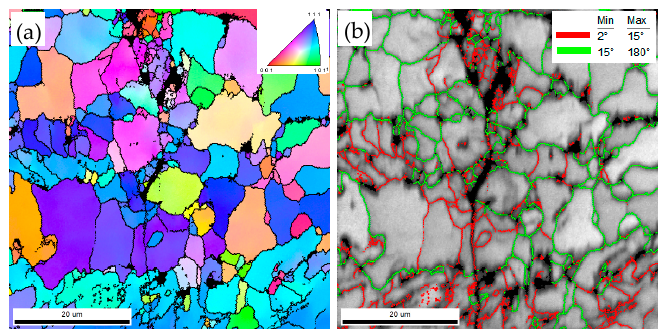
Figure 13. Number fraction of misoriented angles at different peak temperatures.